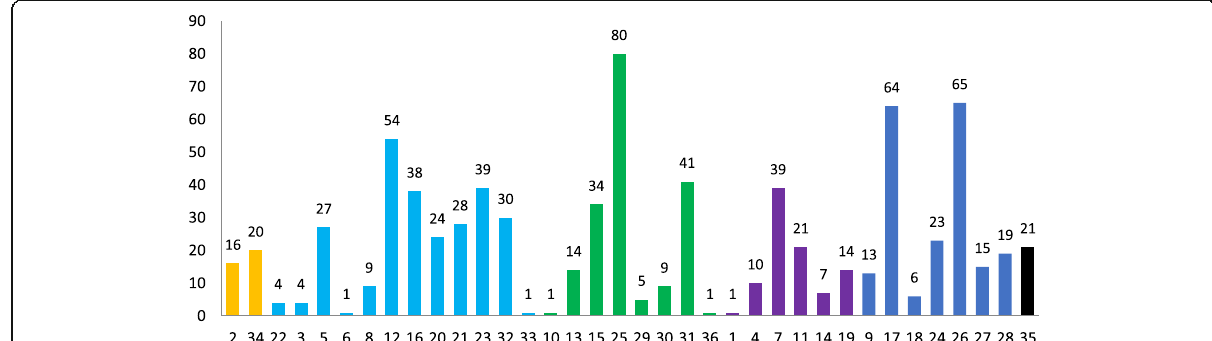
Fig. 6 Publication distribution across all 36 individual journals across different categories with the same color-coded for journals in the same subject category